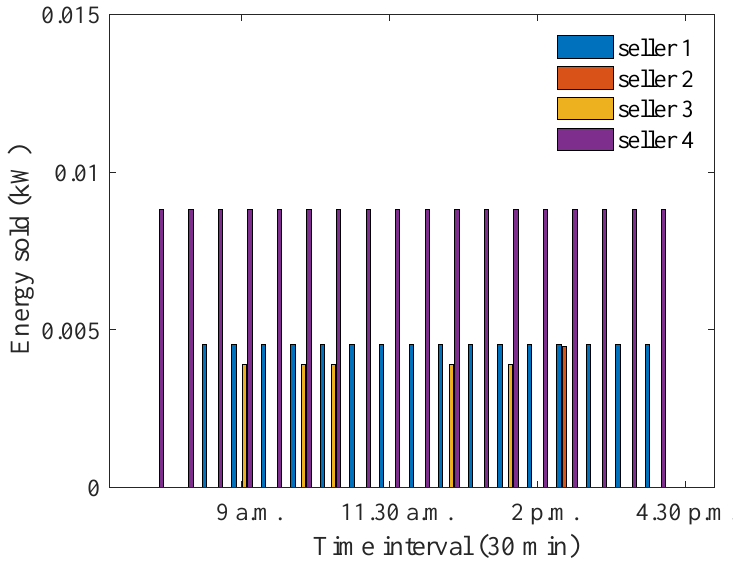
Figure 7. Optimum energy sold for equally preferred sellers and buyers during winter months.